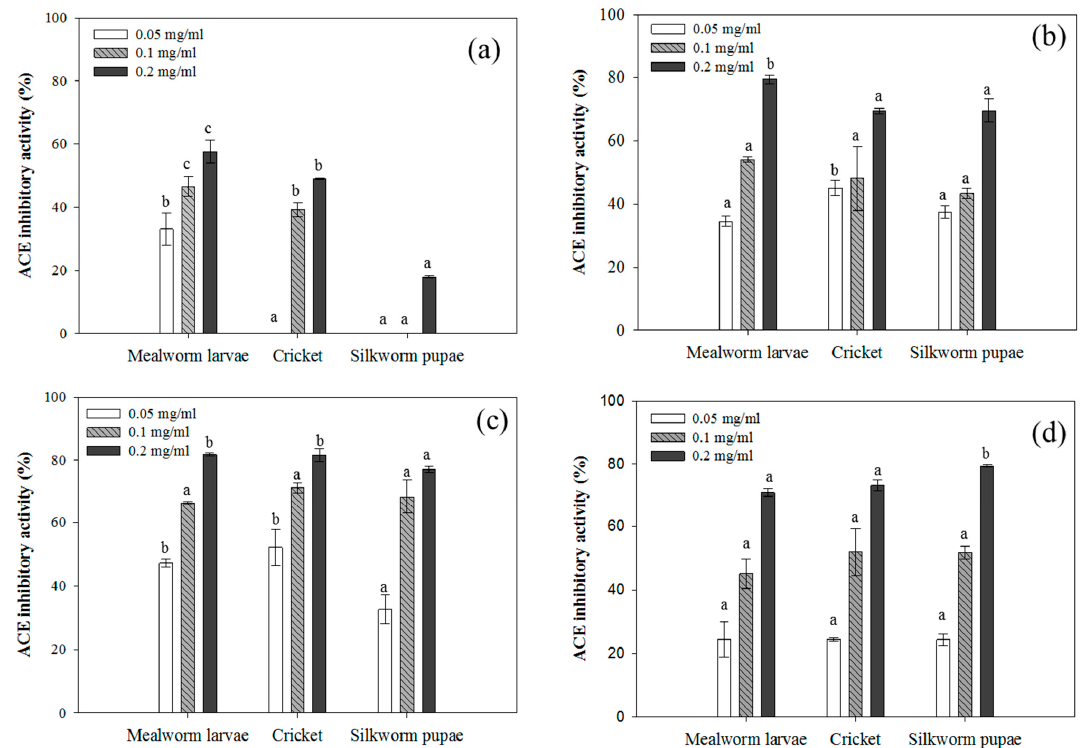
Figure 6. Angiotensin-converting enzyme (ACE) inhibitory activity of ( a ) insect proteins and their hydrolysates following ( b ) Flavourzyme, ( c ) Alcalase, and ( d ) mixture (Flavourzyme + Alcalase) treatments. Each value is expressed as the mean ± SD ( n = 3); values marked with different letters indicate significant differences among treated groups ( p < 0.05).